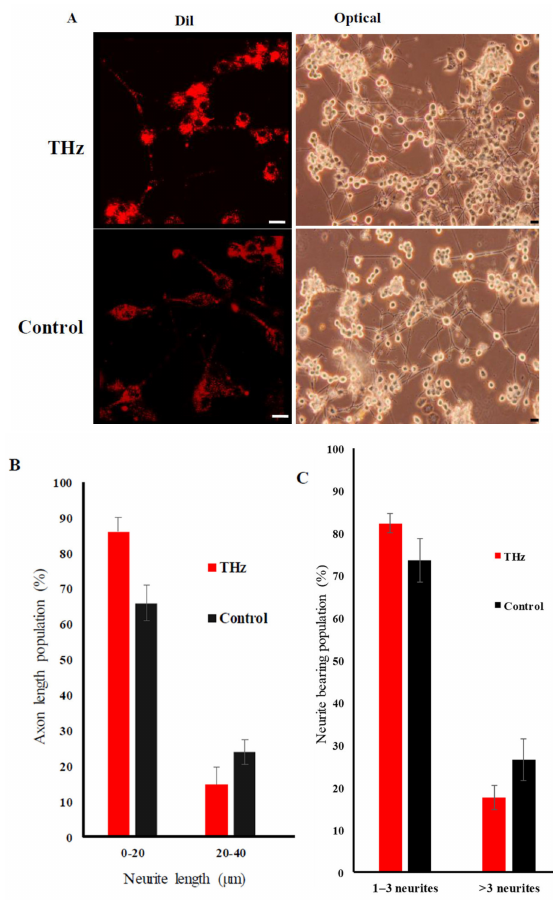
Figure 6. PC 12 cell differentiation at day 7 following exposure to THz radiation. The tissue culture plates were coated with 10 µ g/mL of collagen and PC 12 cells seeded at a density of 10 6 cells/mL. Cells were grown in a low-serum medium with NGF at a concentration of 50 ng/mL. Partial refreshment of the medium was carried out every two days. ( A ) The PC 12 cells were labelled with a lipophilic membrane stain, Dil (1,1 (cid:48) -Dioctadecyl-3,3,3 (cid:48) ,3 (cid:48) -Tetramethylindocarbocyanine Perchlorate). No changes were observed among the THz treated PC 12 cells and the untreated control. Scale bar is 10 µ m. The phase contrast images were captured on day 7 of the PC 12 cell differentiation. Scale bar is 10 µ m. ( B ) Quantification of axon outgrowth. THz treated PC 12 cells and the untreated control was able to undergo neuronal differentiation extending neurites from 0 to >40 µ m in diameter with the THz treated sample and the control mainly having extensions from 0–20 µ m ( p = 0.857) and 20–40 µ m ( p = 0.976). ( C ) Quantification of neurite bearing cell population. More than 80% of the THz treated cell population exhibited 1–3 neurite bearings whereas 73% of the control cell population exhibited 1–3 neurite bearings ( p = 0.855). Even though the THz treated sample demonstrated more neurite bearings in comparison to the control sample, the results were not statistically